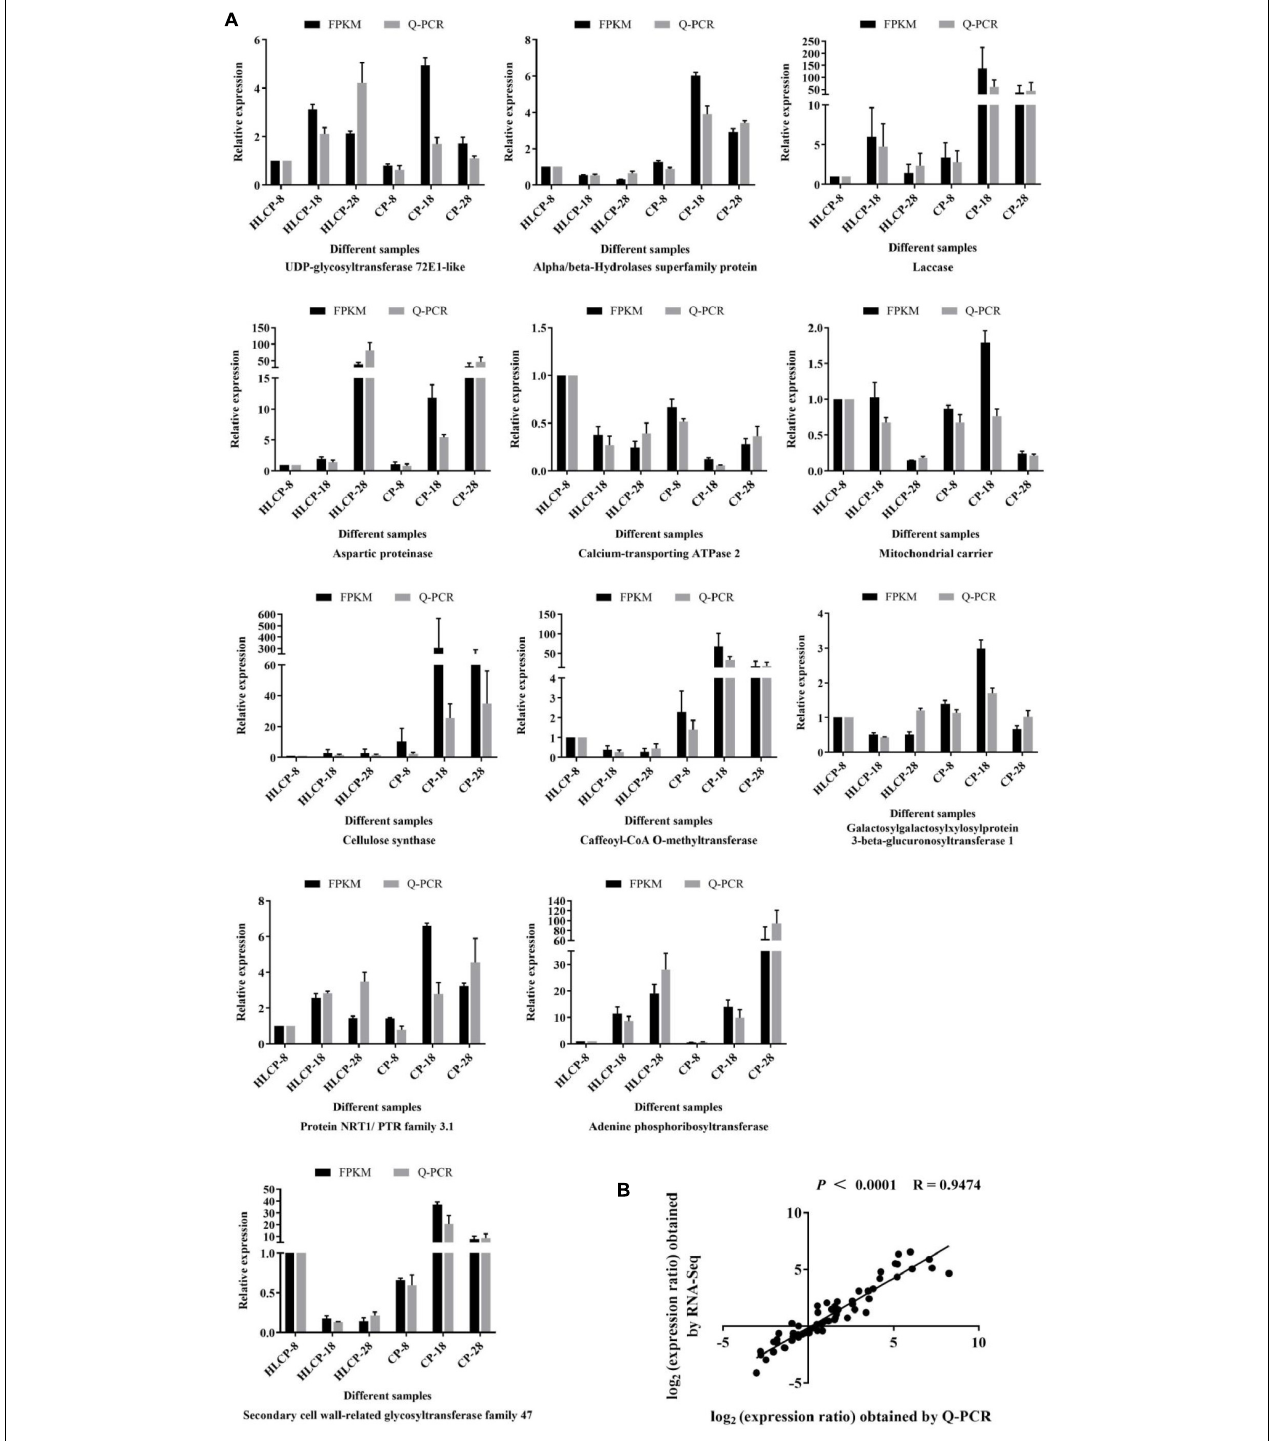
FIGURE 9 | Verification of transcriptome analysis of 12 genes using qRT-PCR. (A) The relative expression levels and RNA-Seq FPKM levels of 12 randomly selected transcripts were verified using qRT-PCR. The black bar indicates the relative expression level of RNA-Seq, which is the FPKM value. The relative gene expression of genes analyzed using qRT-PCR is represented by means of a gray histogram. Error bars represent standard error calculated from three replicates. (B) Correlation analysis of log 2 value between RNA-Seq and qRT-PCR